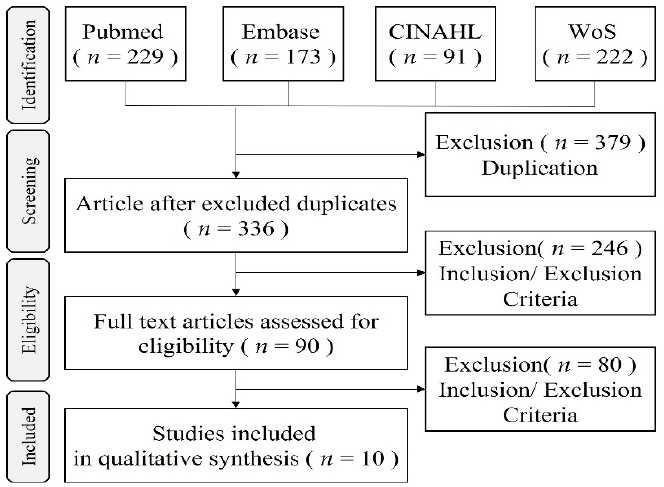
Figure 1. Flow chart of the systemic review in this study.